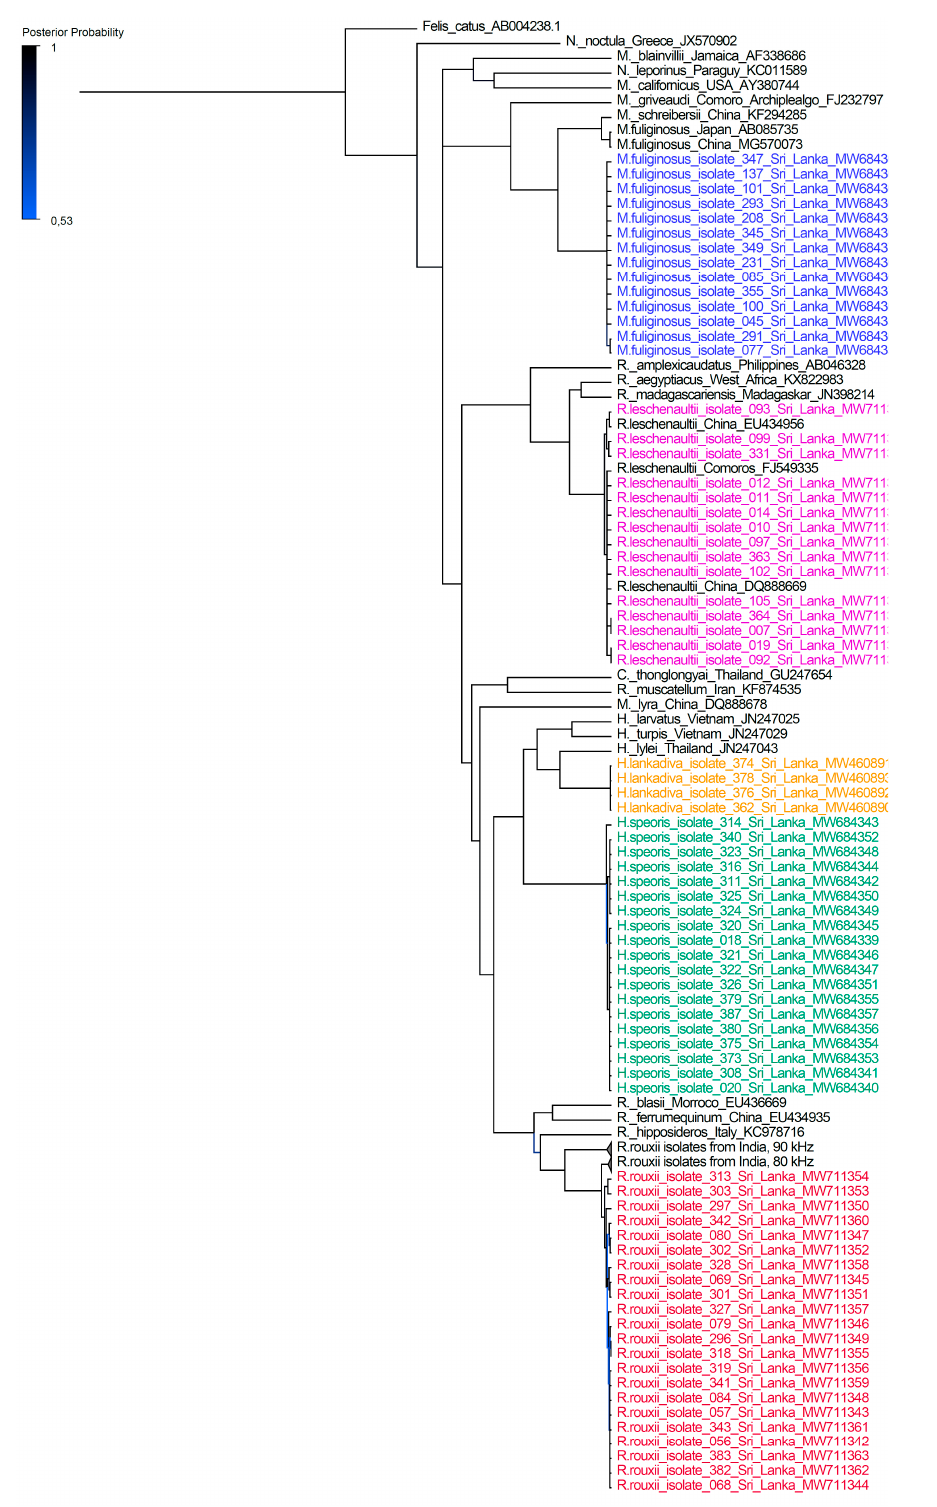
Figure 1. Phylogenetic reconstruction of bat species based on the full mitochondrially encoded cytochrome b gene (1140 bp) in comparison to other species of bats. The posterior probability is displayed as gradient shade of the tree lines ranging from 0.53 to 1.0. Branches of R. rouxii from